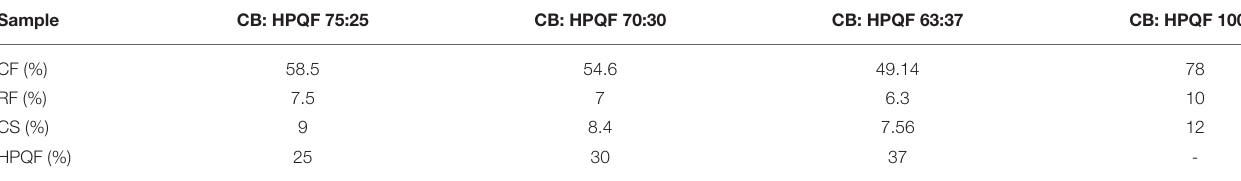
TABLE 1 | Multi-cereal blends (CB) used in the extrusion process.